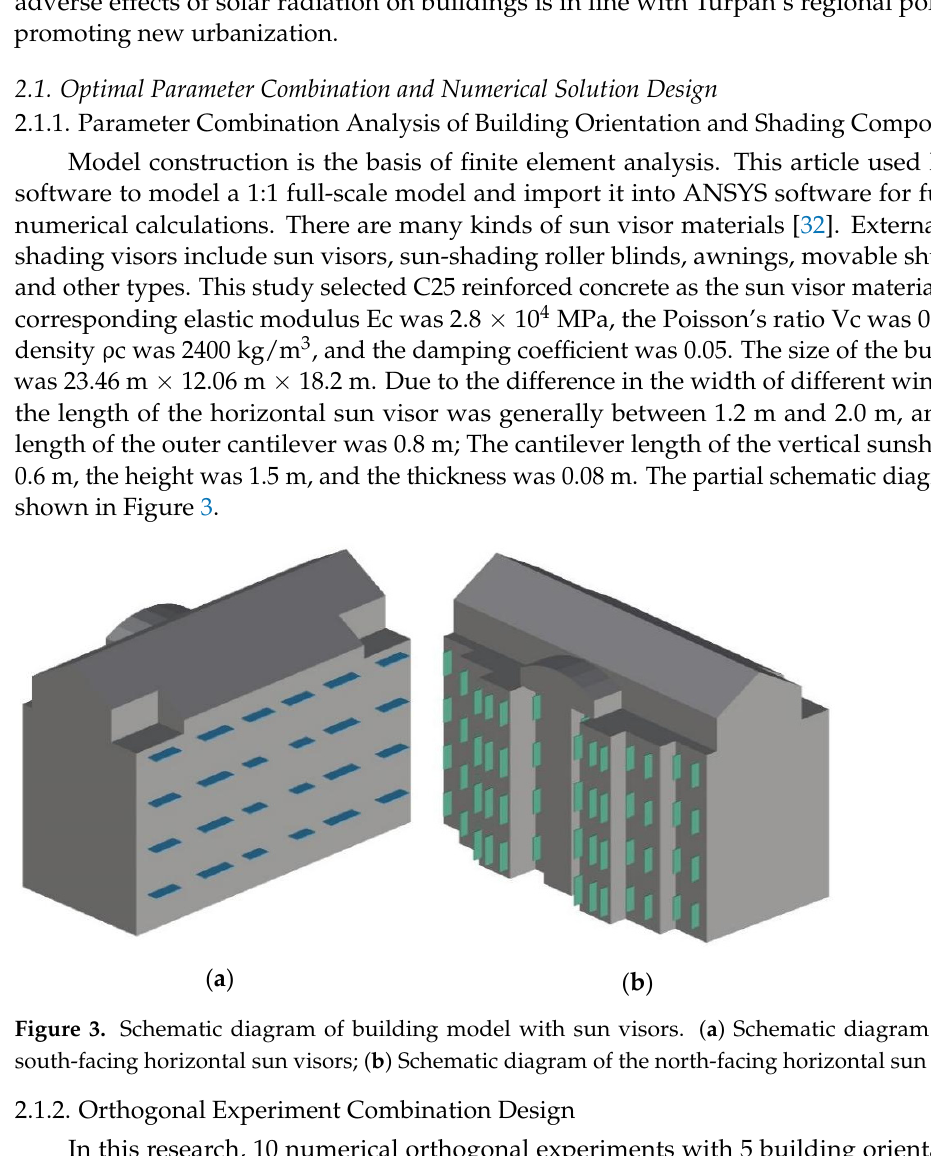
Table 1. Orthogonal experiment table.